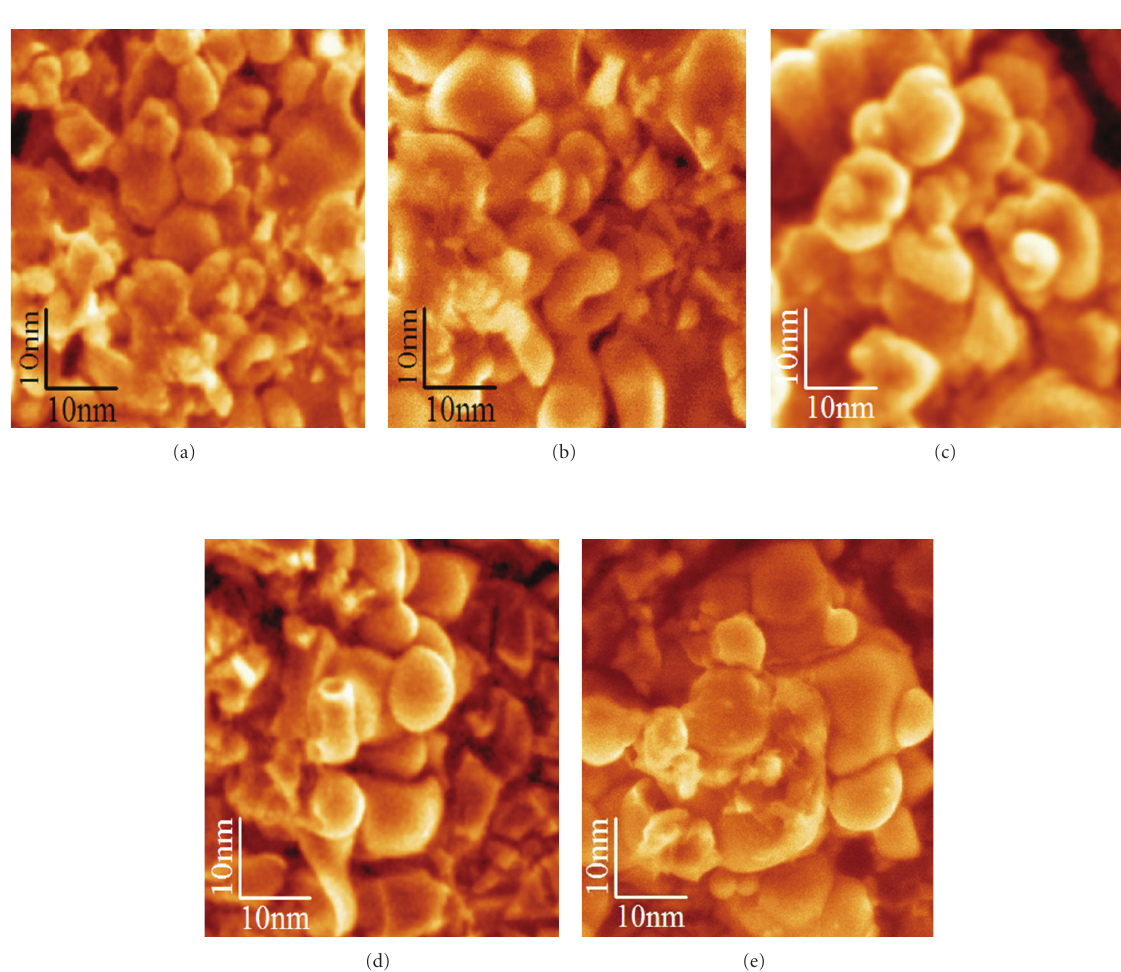
Figure 1: AFM images of silicon deposited on porous aluminum layer (PAL) as a function the anodisation current.